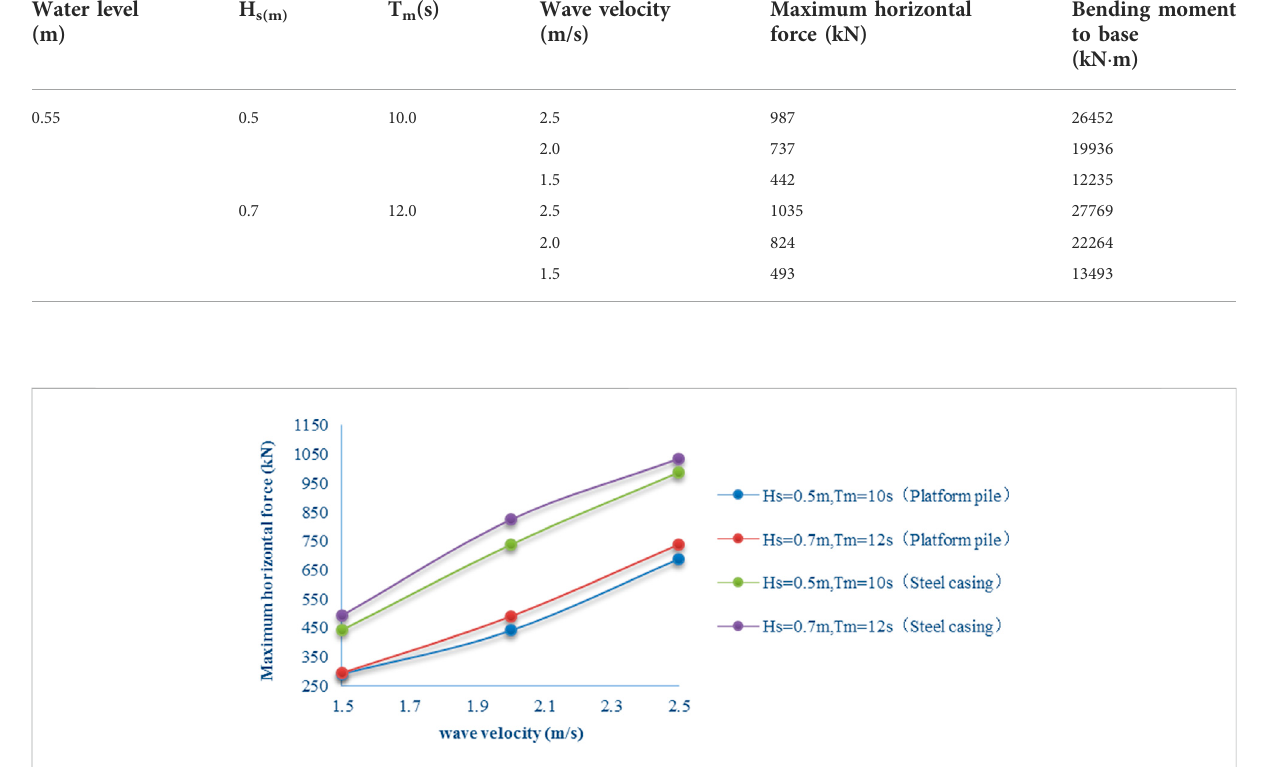
FIGURE 10 Relationship between maximum horizontal force and wave